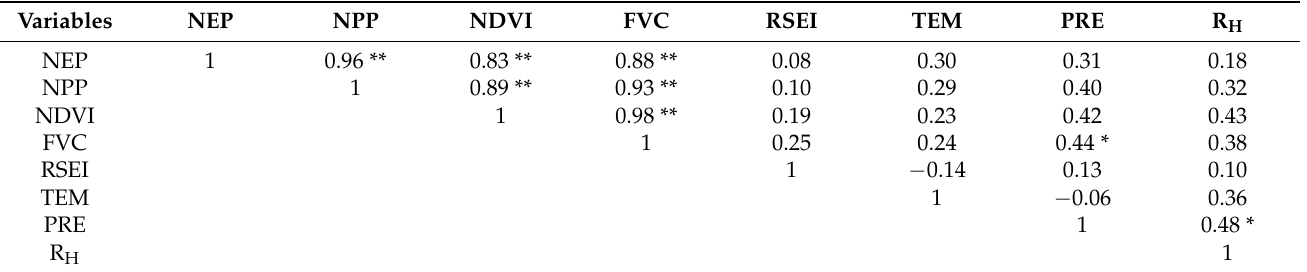
Table 2. Annual average correlation coefficients between NEP, NPP, NDVI, FVC, RSEI, TEM, PRE and R H in NWC from